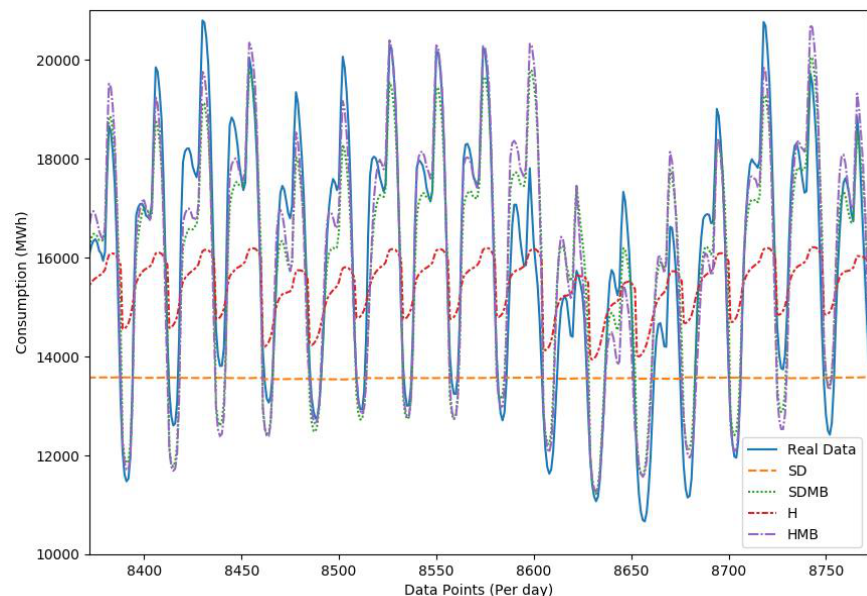
Figure 5. The neural network with the algorithms during testing.